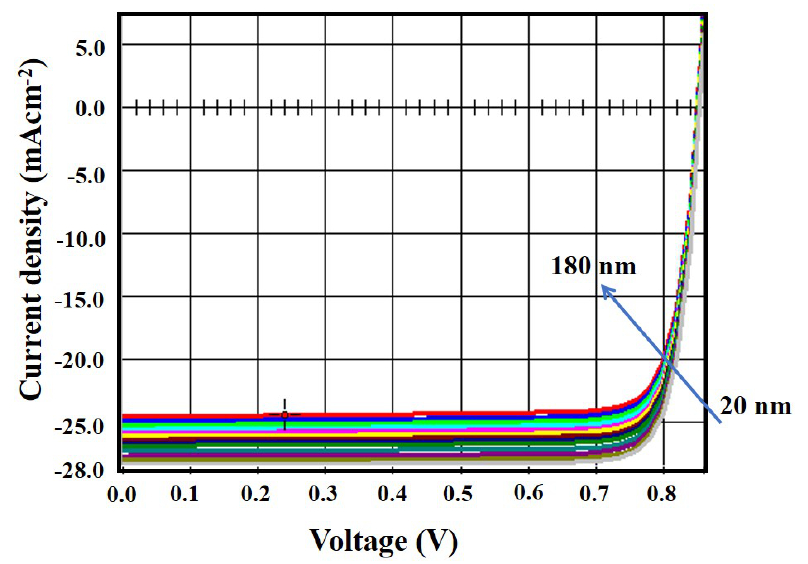
Figure 3. J–V curve with the variation of buffer layer thickness.